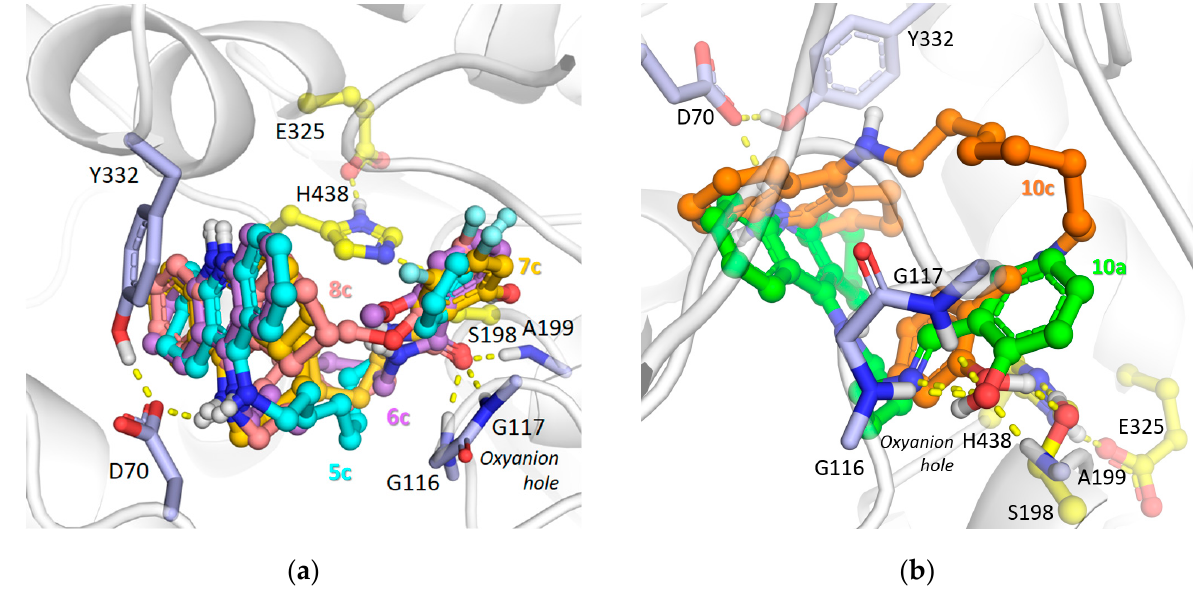
Figure 4. Molecular docking to the BChE active site of conjugates 5c (carbon atoms are colored cyan), 6c (carbon atoms are colored lilac blue), 7c (carbon atoms are colored yellow), 8c (carbon atoms are colored pink) ( a ); and conjugates 10a (carbon atoms are colored green) and 10c (carbon atoms are colored orange) ( b